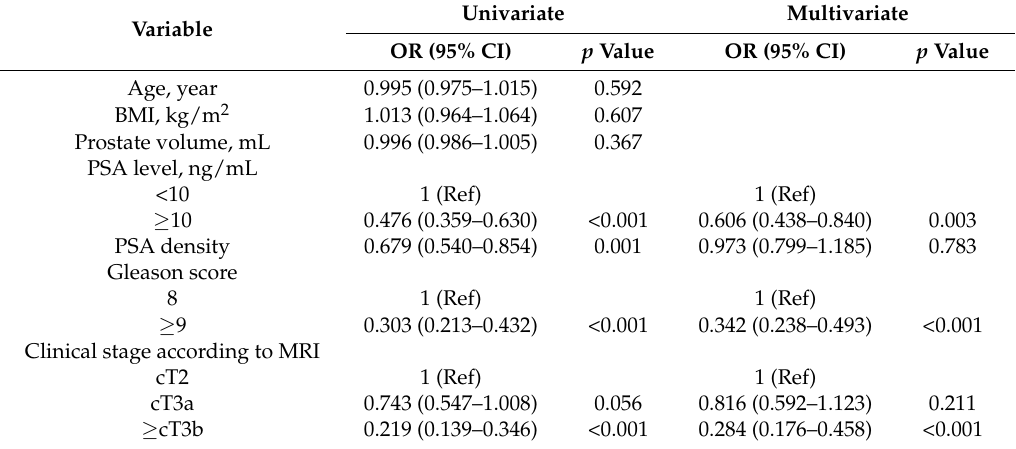
Table 2. Univariate and multivariate analyses of factors associated with pathologic Gleason score downgrade in patients with biopsy Gleason scores